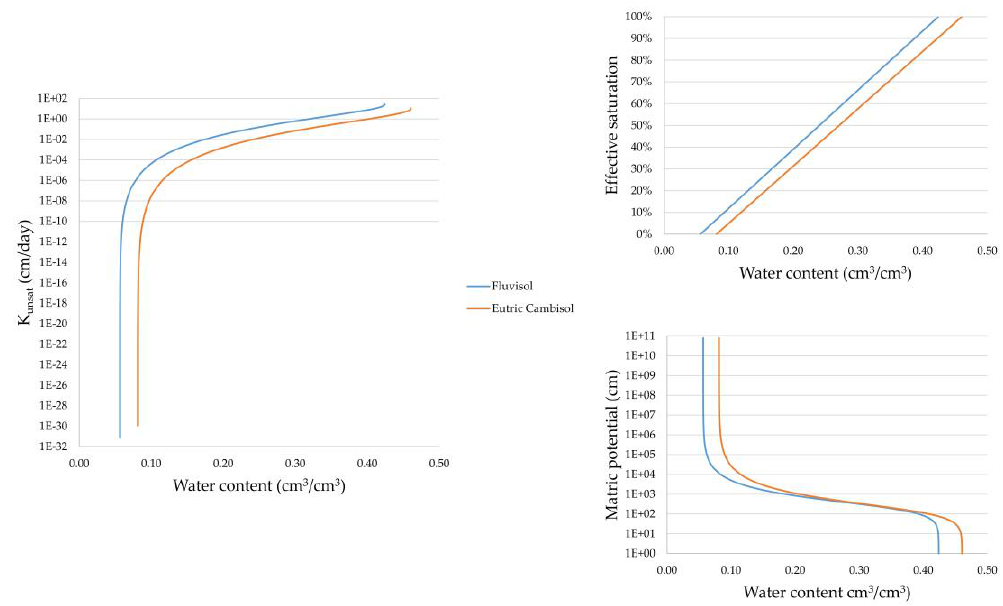
Figure 9. Di ff erence in the SWRCs, e ff ective saturations, and unsaturated hydraulic conductivities Figure 9. Difference in the SWRCs, effective saturations, and unsaturated hydraulic conductivities between the Fluvisols and Eutric Cambisols. between the Fluvisols and Eutric Cambisols. Table 5. Values of the water content and effective saturation that generate impermeability in the investigated soil profiles.